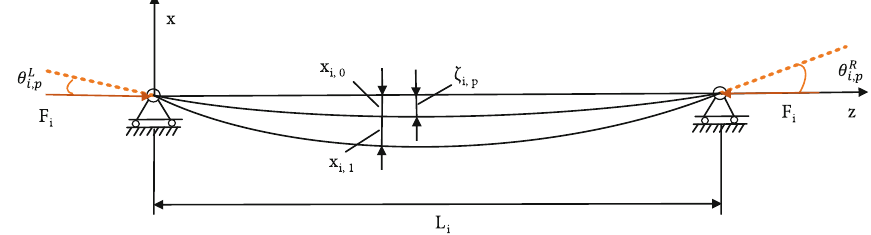
Figure 14: Beam-column with initial